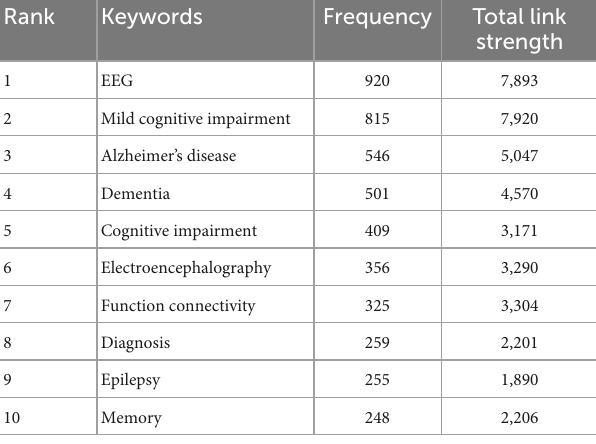
MCI patients had epileptiform activity (Cuesta et al.,